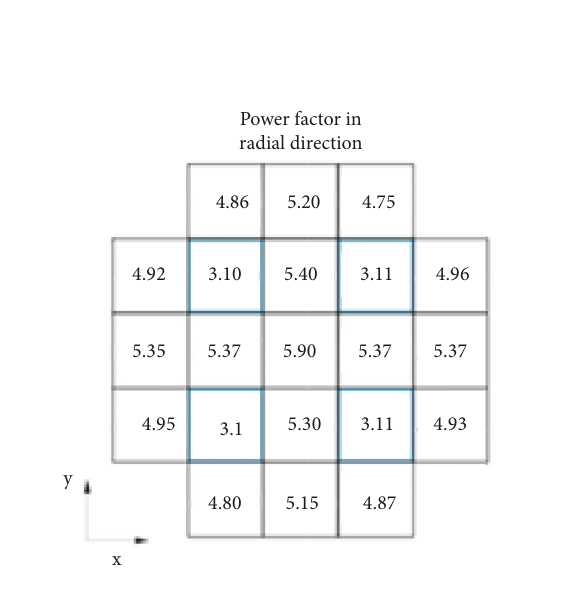
Figure 14: Average fuel assembly power factors from the CARR reactor [7].